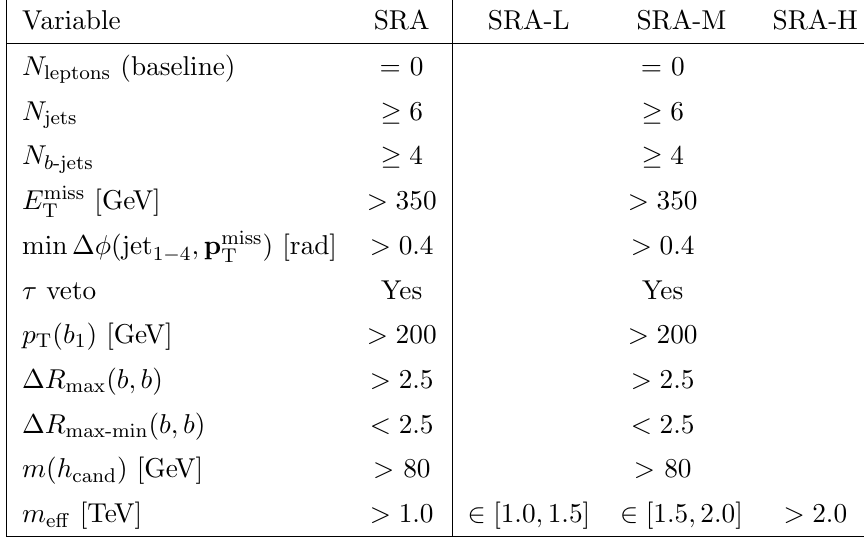
e(cid:11) intervals used. The letter